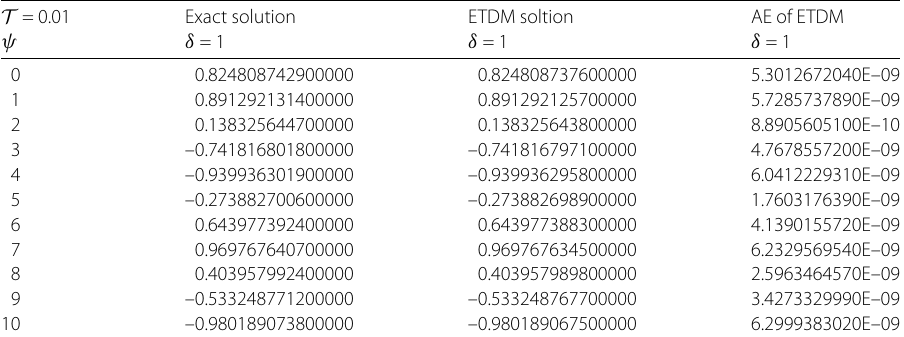
Table 2 ν ( ψ , ζ , T ) Comparison of Exact soltion, ETDM and ETDM Error of example 1 at ρ = 1 T = 0.01